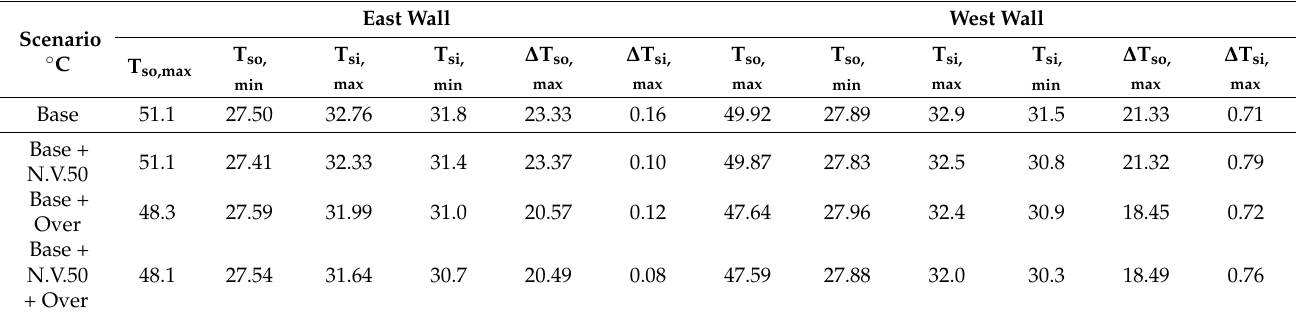
Table 7. Thermal inertia of the envelope in the studied cases for east and west